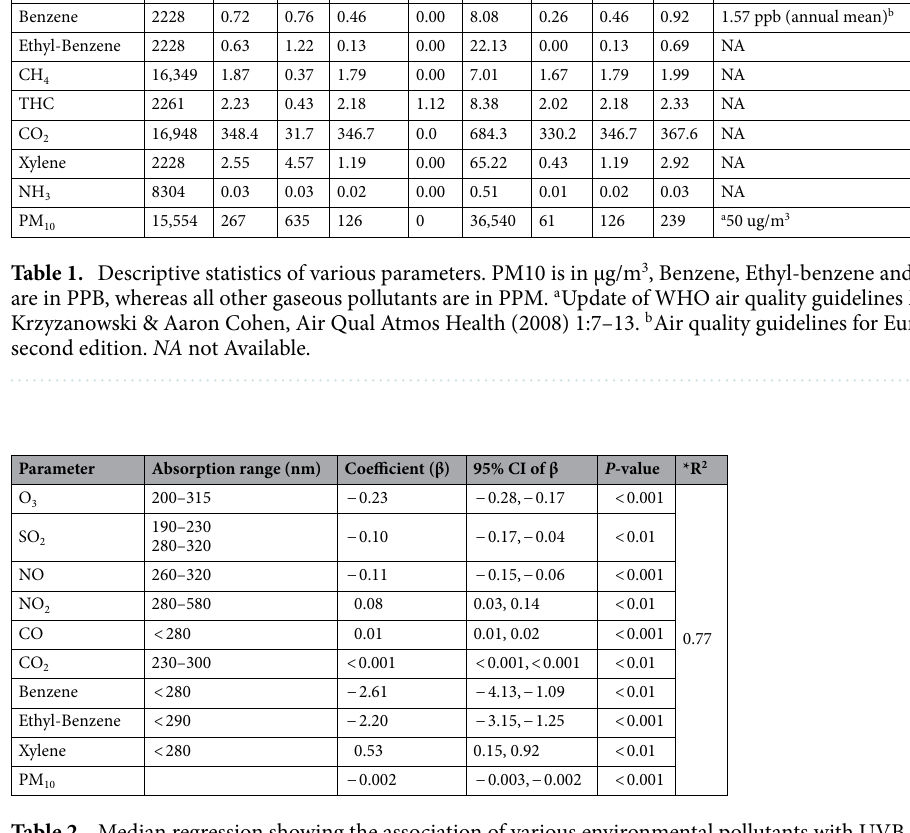
Table 2. Median regression showing the association of various environmental pollutants with UVB intensity at the earth’s surface. *Pseudo R 2 . The full model included SO 2 , H 2 S, NO, NO 2 , CH 4 , NCH 4 , THC, O 3 , CO, CO 2 , NH 3 , Benzene, Toluene, Ethyl-benzene, Xylene, PM 10 , Total solar output, Temperature, Relative humidity, Hour of the day, Season, Station and Year. PM 10 is in µg/m 3 ; Benzene, Ethyl-benzene and Xylene are in PPB, other gaseous pollutants are in PPM. Parameters shown in the table were selected in the backward selection in the final model. Final model also included total solar output, relative humidity, year and season which are not shown in the table.